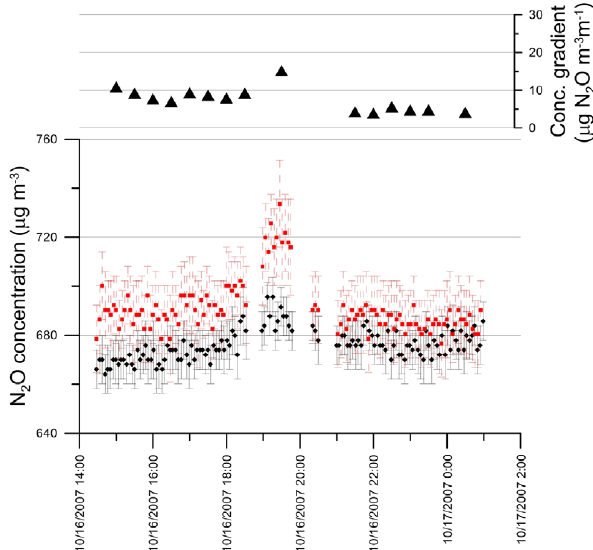
Fig. 9. Temporal variation of the N 2 O concentrations in ambient air (16–17 October 2007) at both heights (0.5m: side-oriented squares, 2.7m: edge-oriented squares), including the statistical errors (random absolute error as columns around the measurement value in both directions) and concentration gradients.